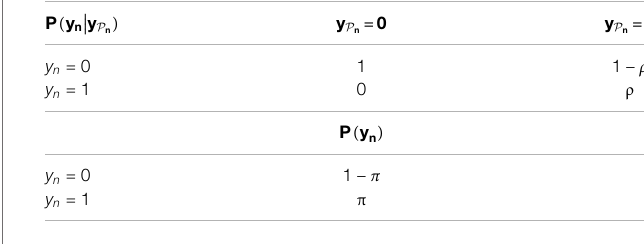
TABLE 1 | Class transition probability and prior